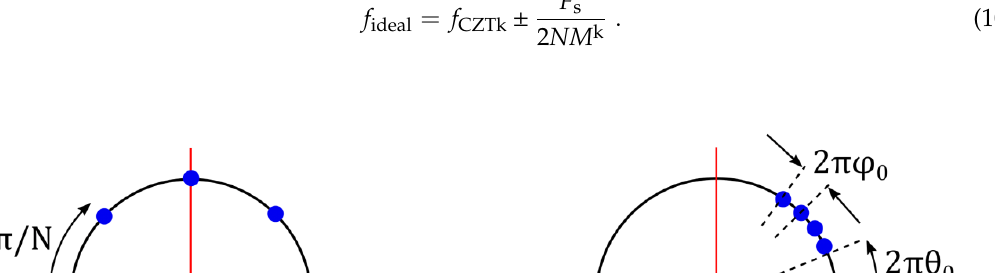
Figure 3. Comparison of the distance measurement error with the FFT and CZT.